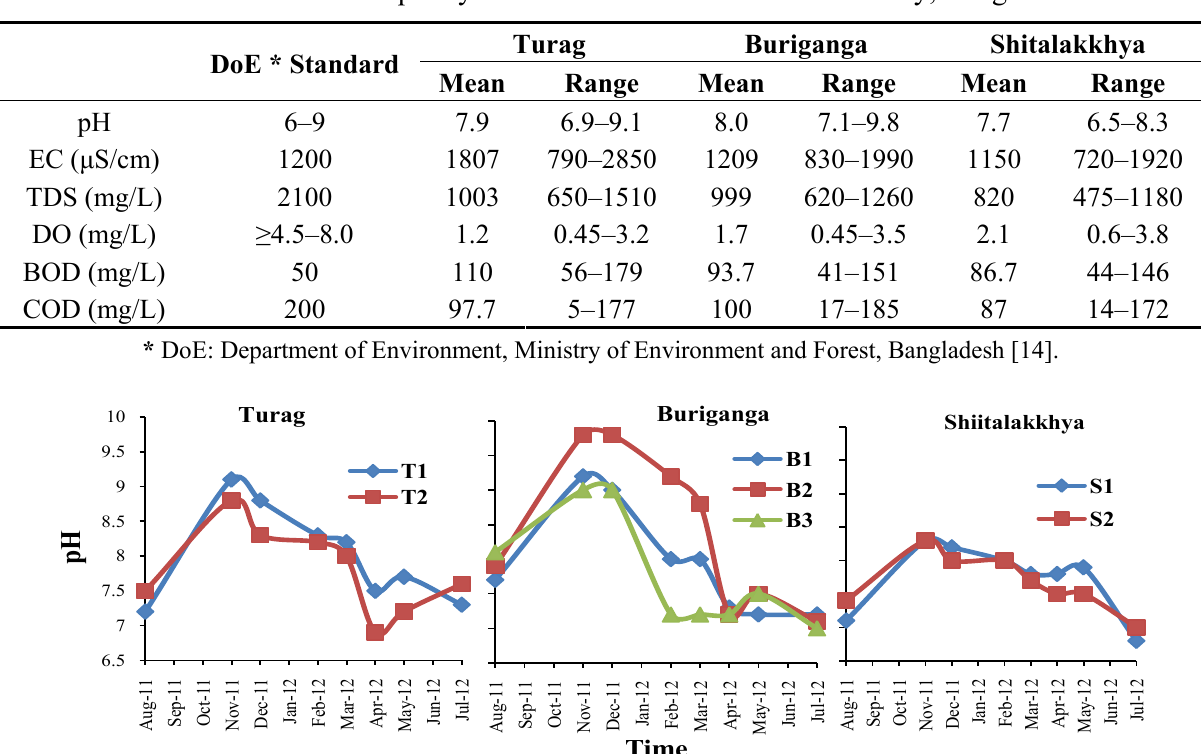
Table 1. General water quality of the three rivers around Dhaka City, Bangladesh.